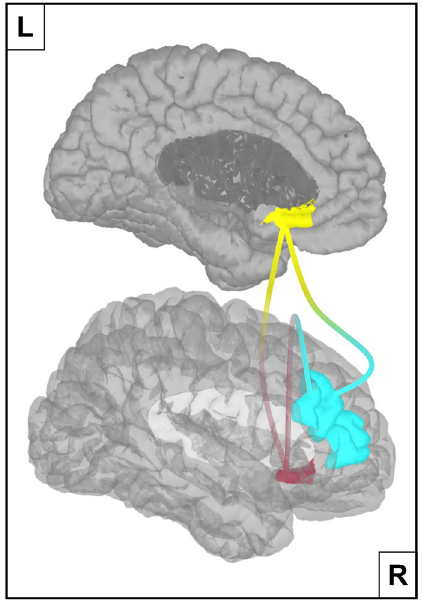
Figure 3. Diminished Amplitude Envelope Correlation connectivity in MDD patients. Depressed patients show reduced functional connectivity in the beta-1 (13–17 Hz) band for the following three ROI pairs: left sgACC (yellow)—right DLPFC (turquoise), right sgACC (red)—right DLPFC and left sgACC—right sgACC. This result was obtained after FDR thresholding. MDD: Major Depressive Disorder, sgACC: subgenual Anterior Cingulate Cortex, DLPCC: Dorsolateral Prefrontal Cortex, FDR: False Discovery